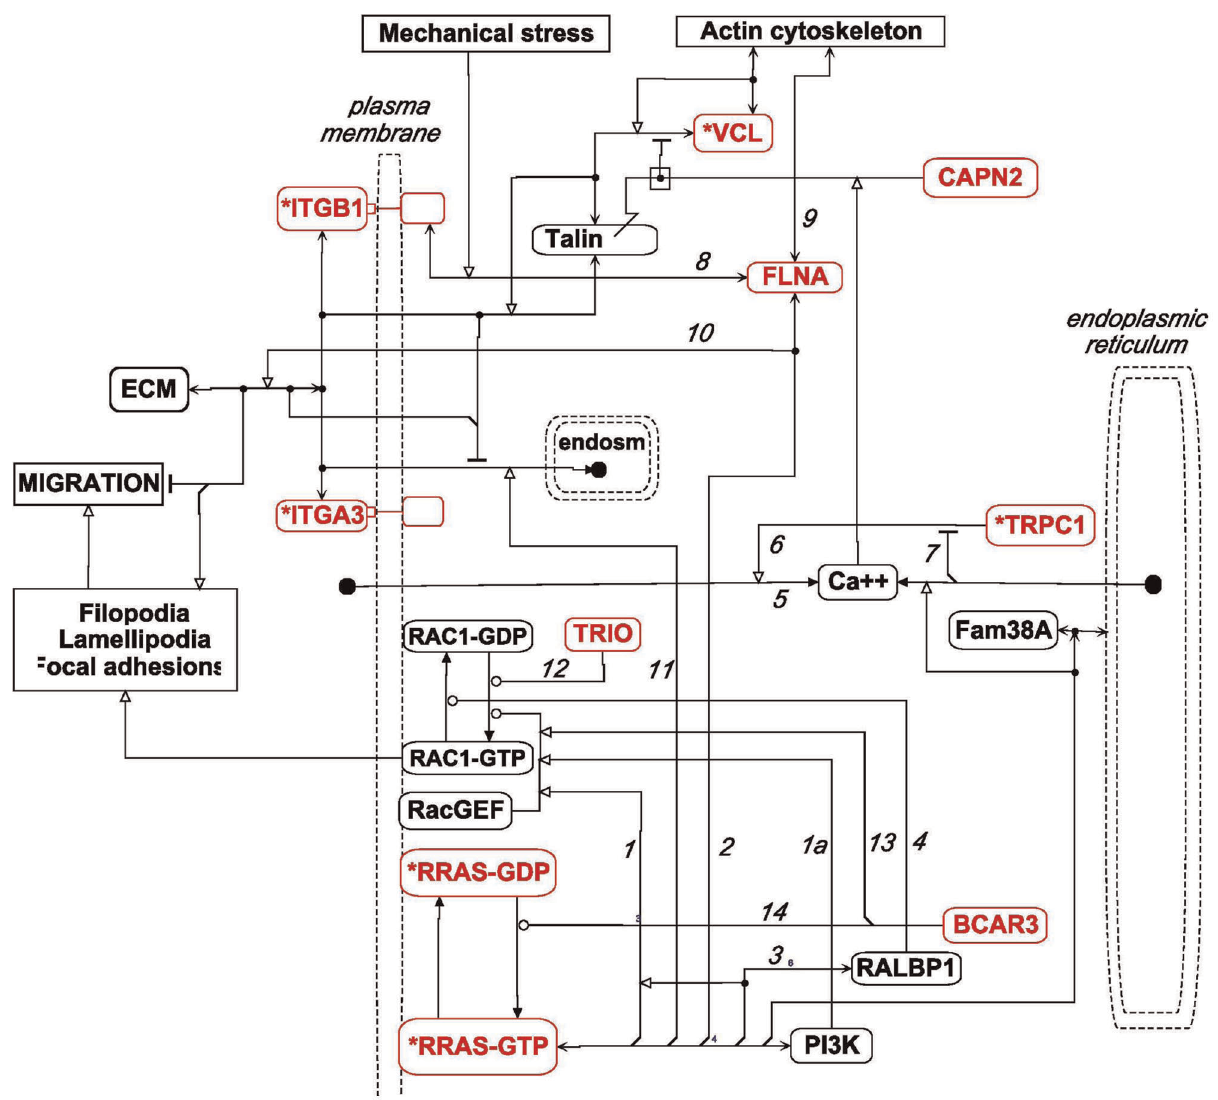
Figure 11. MIM of the role of RRAS and calcium in the regulation of linkage between integrins and actin cytoskeleton, including participation of relevant genes from the HCCS66 gene set. HCCS66 genes are colored red; those from the original HCCS15 set are also marked with an asterisk. The interactions of Fam38A and CAPN2 are described in Figure 8 and related text. ER, endoplasmic reticulum. (MIM symbol definitions are summarized in Figure